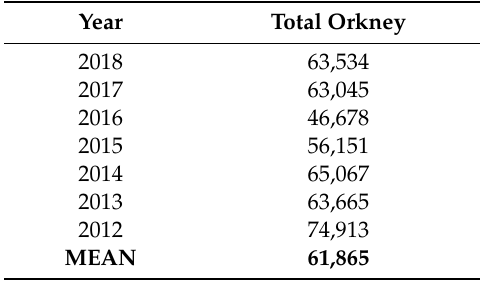
Table 2. Winter (November) Count Totals—resident and migratory